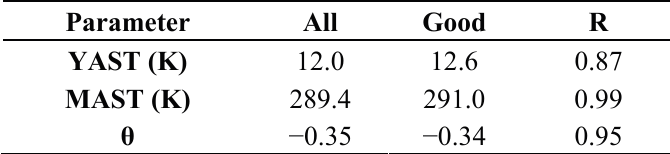
Table 1. Mean ACP for tile h 18 v 04 for 2011–2012 for all produced values, good QA only, and correlation coefficient between